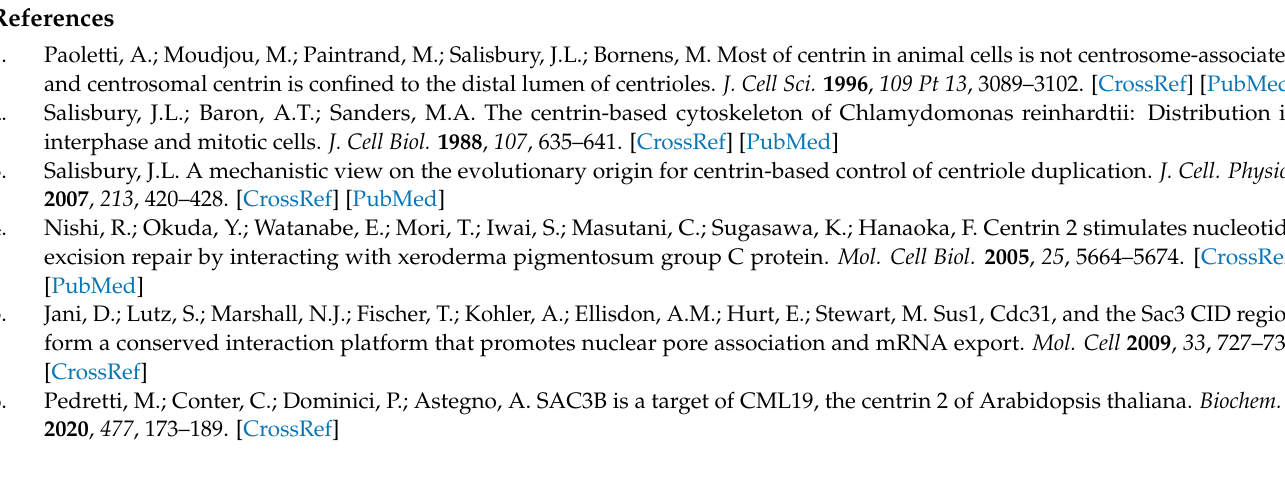
TgCEN1. Figure S3: Far-UV CD analysis of R17 binding to intact TgCEN1 and its isolated domains in the presence of CaCl 2 or EGTA. Figure S4: Far-UV CD analysis of R12 binding to intact TgCEN1 and its isolated domains in the presence of CaCl 2 or EGTA. Figure S5: 2D 15 N, 13 C filtered NOESY spectra of 15 N-labeled Ca 2+ -TgCEN1 (orange) and of unlabeled R12 peptide bound to uniformly 15 N-labeled Ca 2+ -TgCEN1 (black). Figure S6: Far-UV CD spectra of 20 µ M R10 (A), R17 (B) and R12 (C) peptides in various water/TFE mixtures at 25 ◦